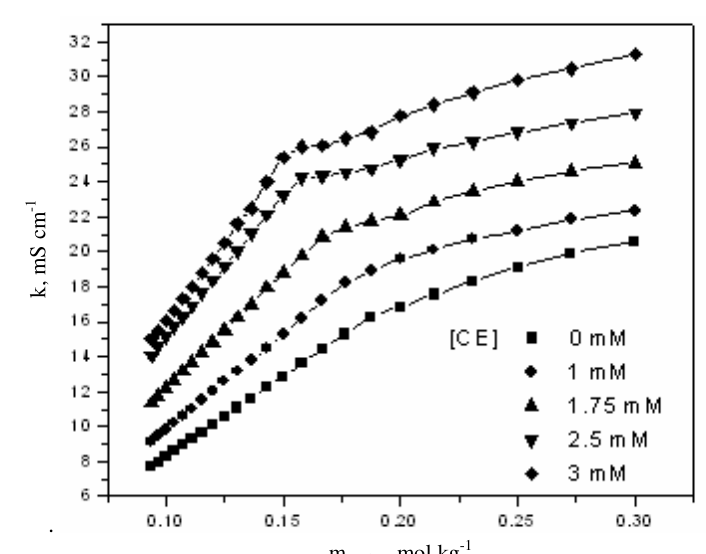
Figure 1. Conductive plots for TEAB/CE/W ternary systems at 298.15K for different concentrations of crown ether.